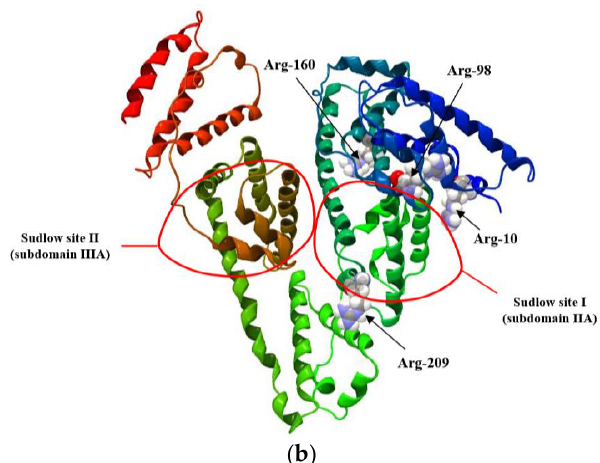
Figure 1. Human serum albumin drug binding sites with the location of main ( a ) lysine (Lys) and ( b ) arginine (Arg) residues involved in in vitro glycation. Molecular graphic image was produced using the CLC Drug Discovery Workbench version 1.0.2. [License: CLC-LICENSE-51JT8-DXYBY-2A3EW- ED80P-DGW80].